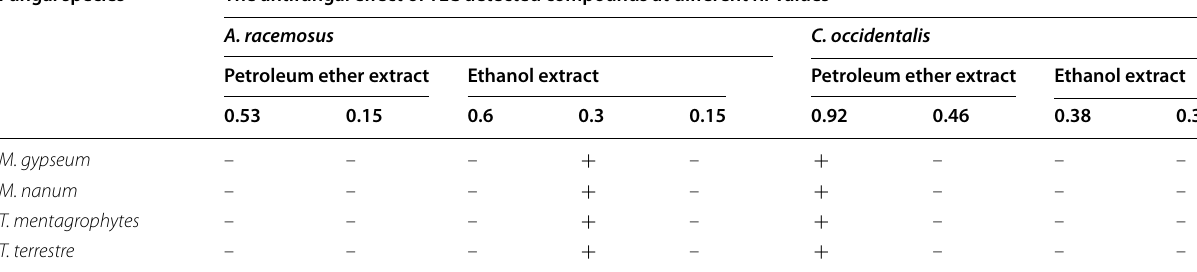
Table 2 Efficacy of antifungal zones located on TLC Fungal species The antifungal effect of TLC detected compounds at different Rf values